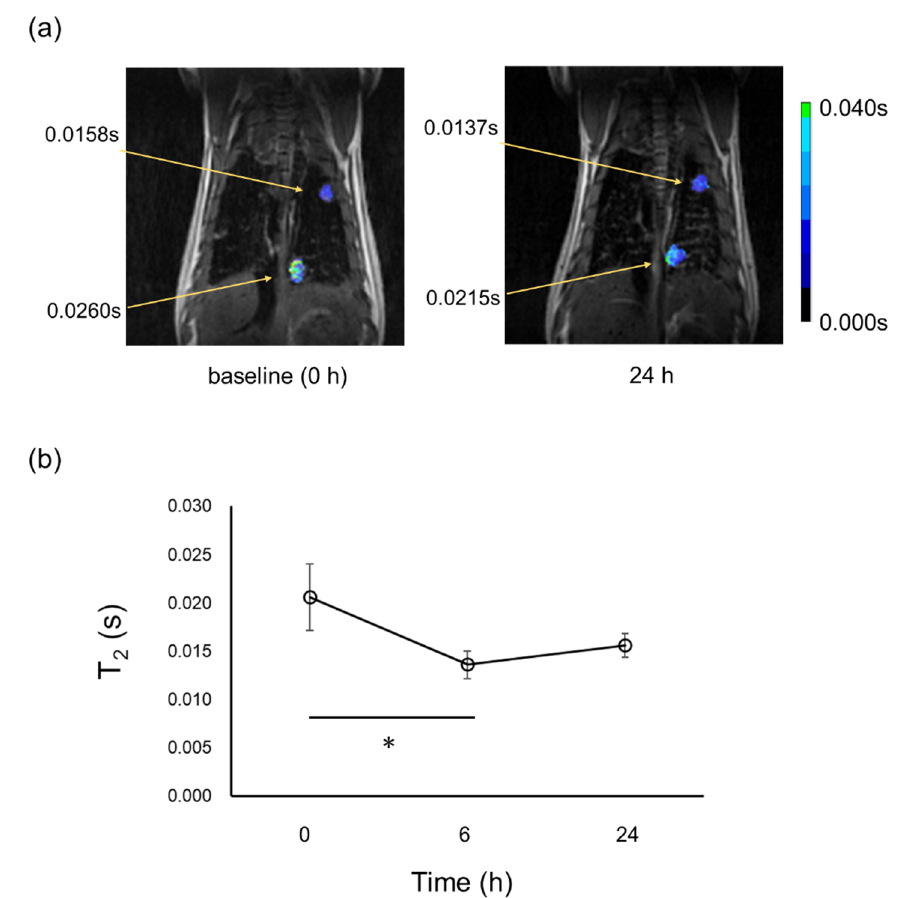
Figure 6. Representative T2 map at cancer sites superimposed on proton MRI of one LC mouse acquired at baseline (0 h) and 24 h after FA@Dex-IONPs administration ( a ), and temporal change of T2 values at cancer sites ( b ). T2 values at cancer sites are also included in ( a ). Significant differences between two time points are indicated by solid line (*: p < 0.05).